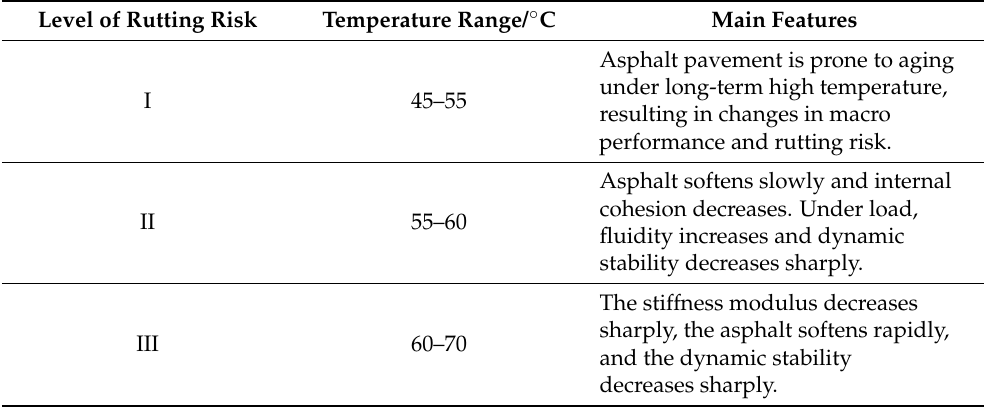
Figure 1. Typical rutting damage of highways in the Hami area. Table 1. Rutting risk level of different pavement temperature ranges [27].